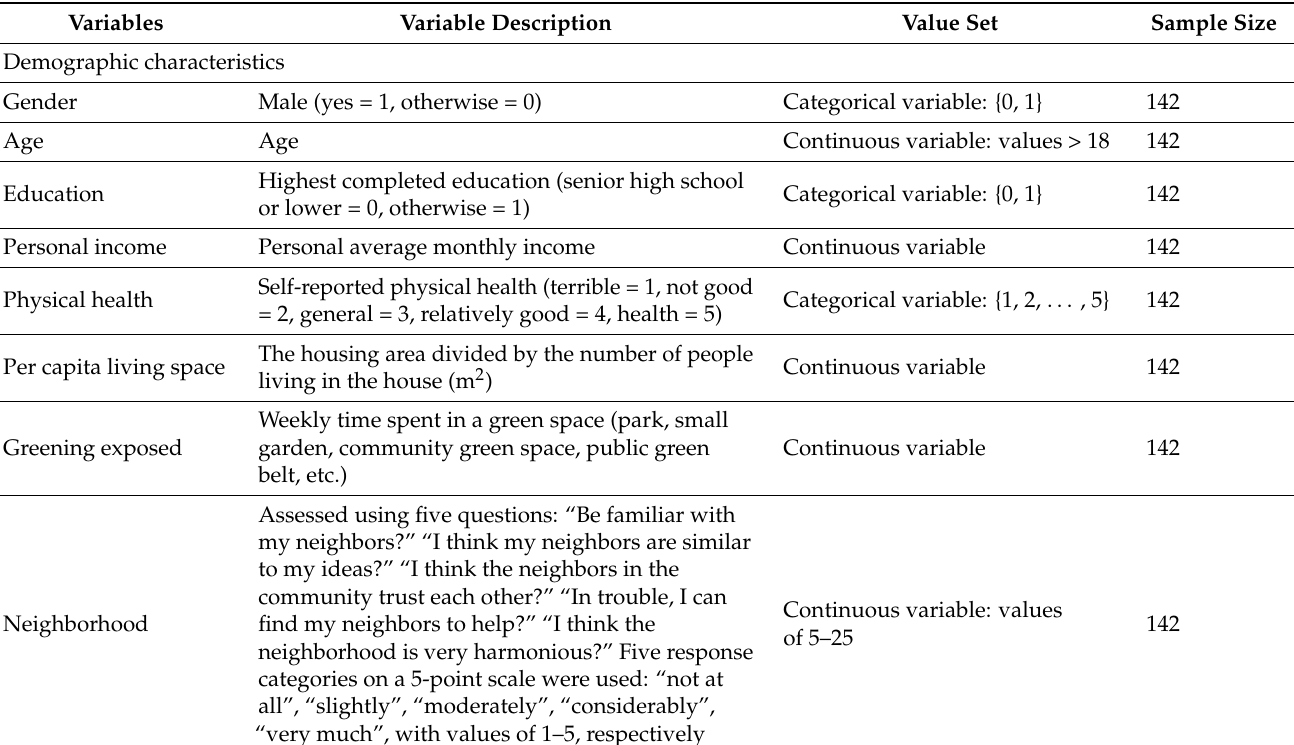
Table 1. Description of